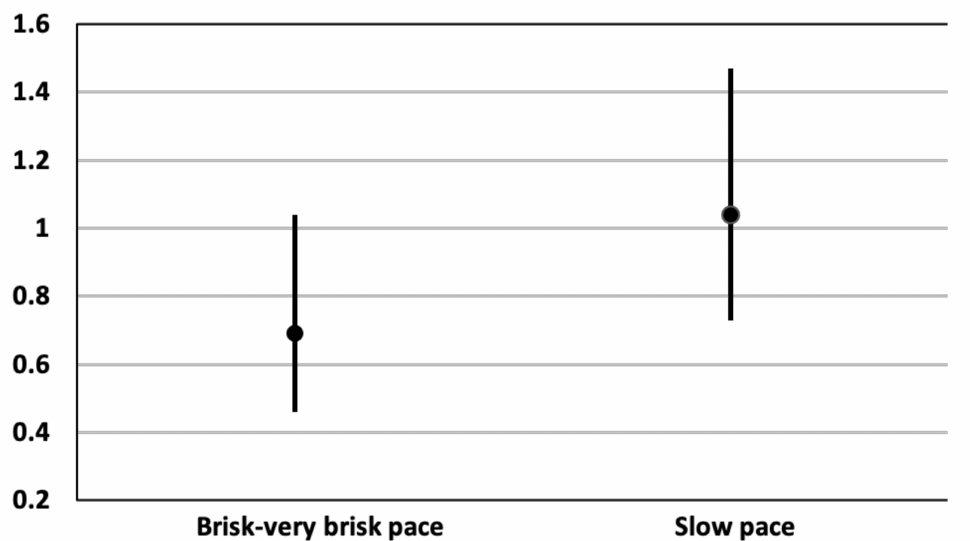
Figure 2. Adjusted * hazard ratios for T2D of the replacement of 1 h sitting time by 1 h of walking according to pace. * Adjusted for sex, soft drinks consumption (tertiles), smoking, family history of diabetes, prevalent hypertension, cancer, cardiovascular disease, snacking, Mediterranean diet score, and baseline overweight/obesity, stratified by decades of age and recruitment period. Additionally, adjusted for MPA and VPA in the replacement of 1 h sitting time by 1 h of slow pace model and for LPA and VPA in the replacement of 1 h sitting time by 1 h of the brisk/very brisk pace